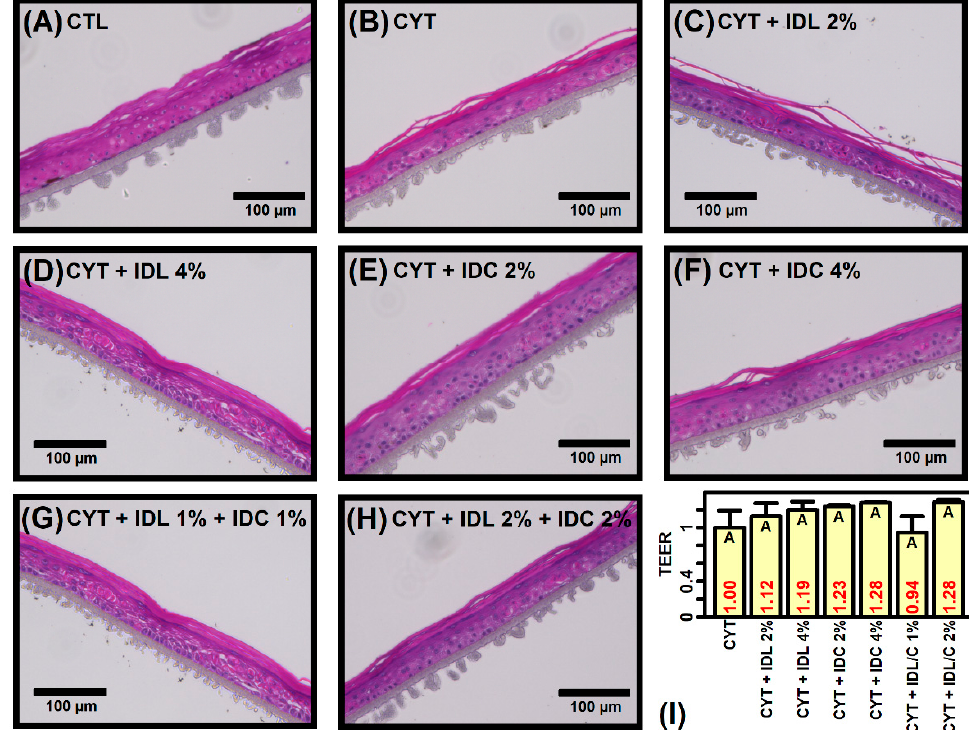
Figure 1. H&E stains and transepithelial electrical resistance (TEER) measurements. ( A – H ) H&E stains. Tissues were treated with vehicle only (CTL) or cytokine cocktail (IL-4, IL-13, IL-31 and TNF- α ) with or without test compounds (IDL or IDC) at different concentrations. ( I ) TEER measurements. The average value of 3 replicates per group is shown (±1 standard error). Groups without the same letter differ significantly ( p < 0.05, Fisher’s least significant difference).